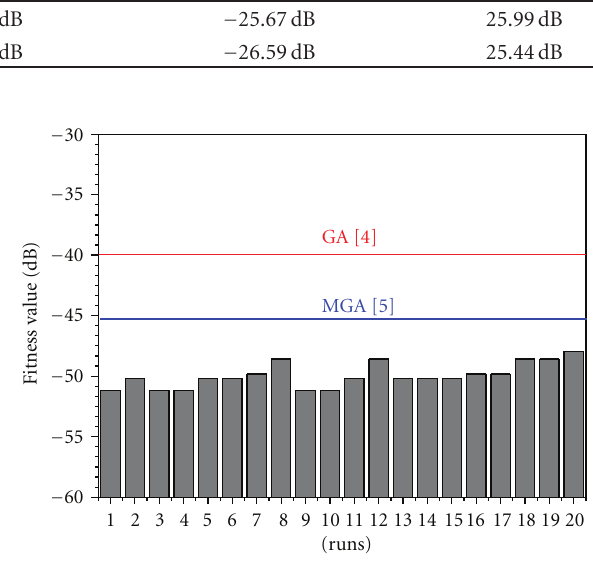
Figure 3: The fitness value of the objective function with (7) ob- tained by the OGA in 20 runs.